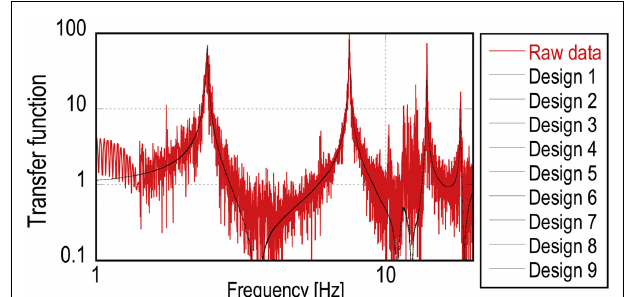
FIGURE 10 | Comparison of transfer functions (raw data VS ARX model) .